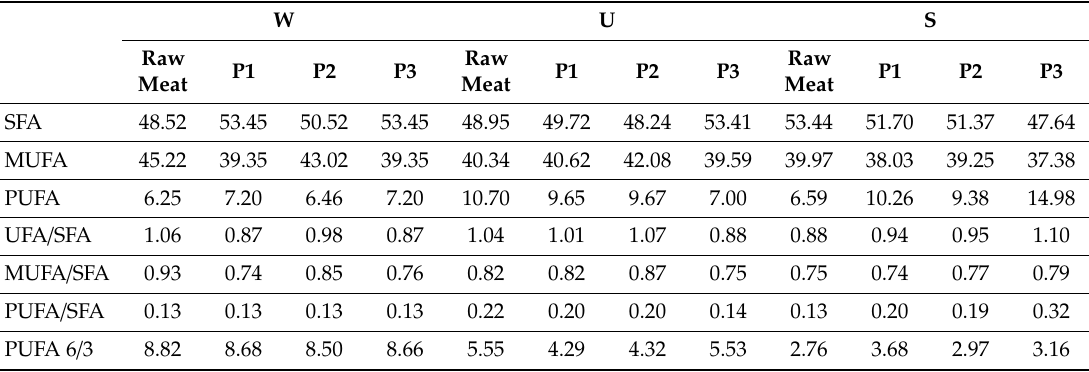
Table 4. Fatty acid composition (%) of raw meat and fermented lamb loin. P1–P3 types of treatment: P1—treatment with sea salt and sodium nitrate, P2—treatment with sea salt, and P3—treatment with sea salt and fermented milk.